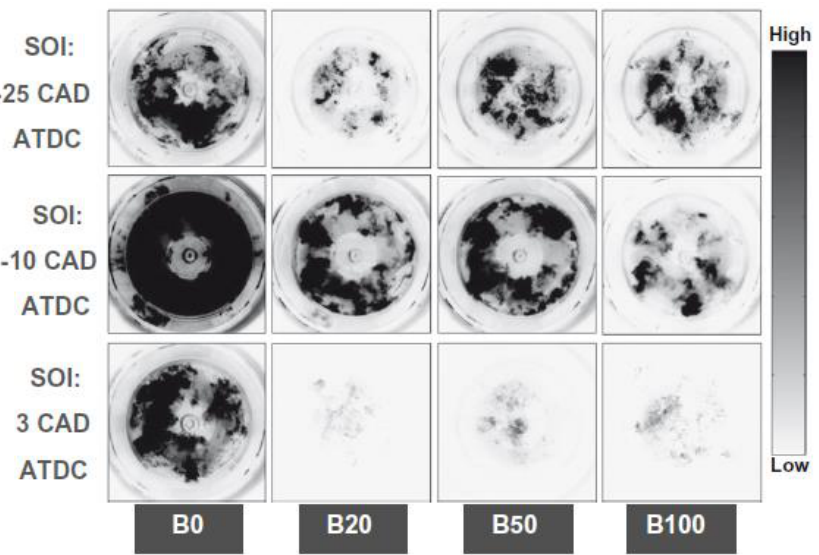
Figure 13. Combustion images at di ff erent crank angles under various biodiesel blending ratios [101]. SOI: start of injection.